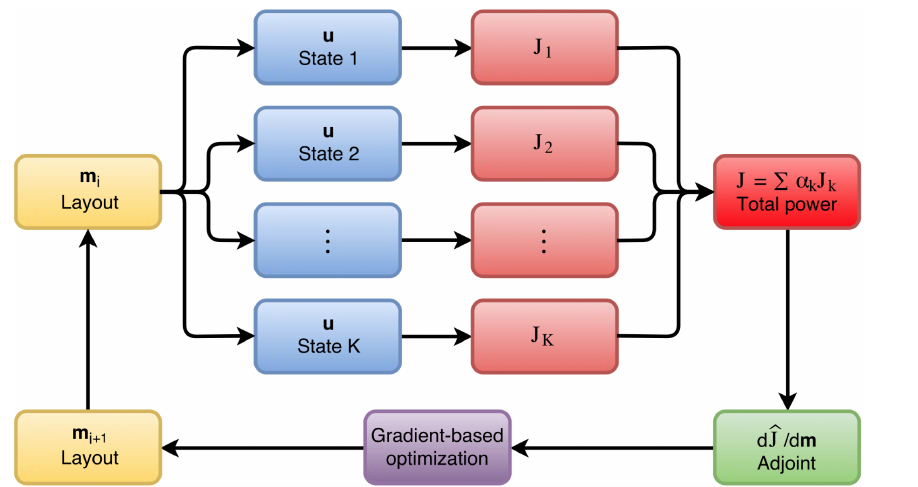
Figure 3. Schematic of the multilevel optimization process for a wind plant with K wind states (i.e., wind speeds and